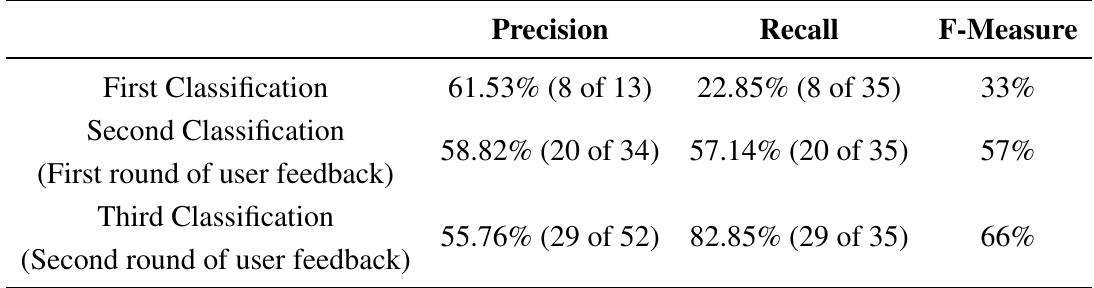
Table 2. Accumulated results of the quantitative evaluation of our ground truth